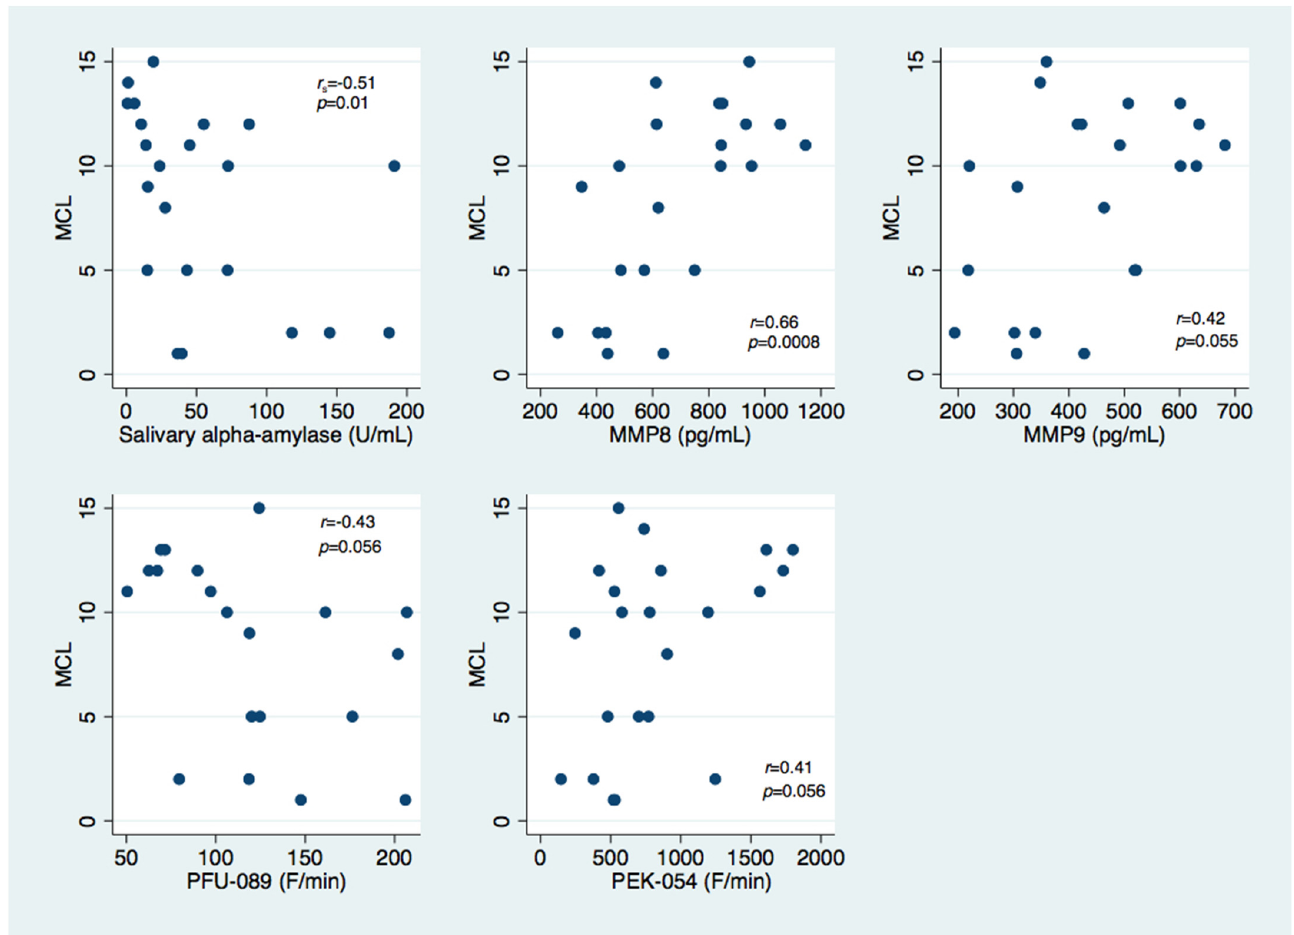
Figure 1. Scatter plot illustrating the relationship between MCL values and enzymatic activity levels for sAA, MMP-8, MMP-9, and total protease activity (using PFU-089 and PEK-054 substrates).